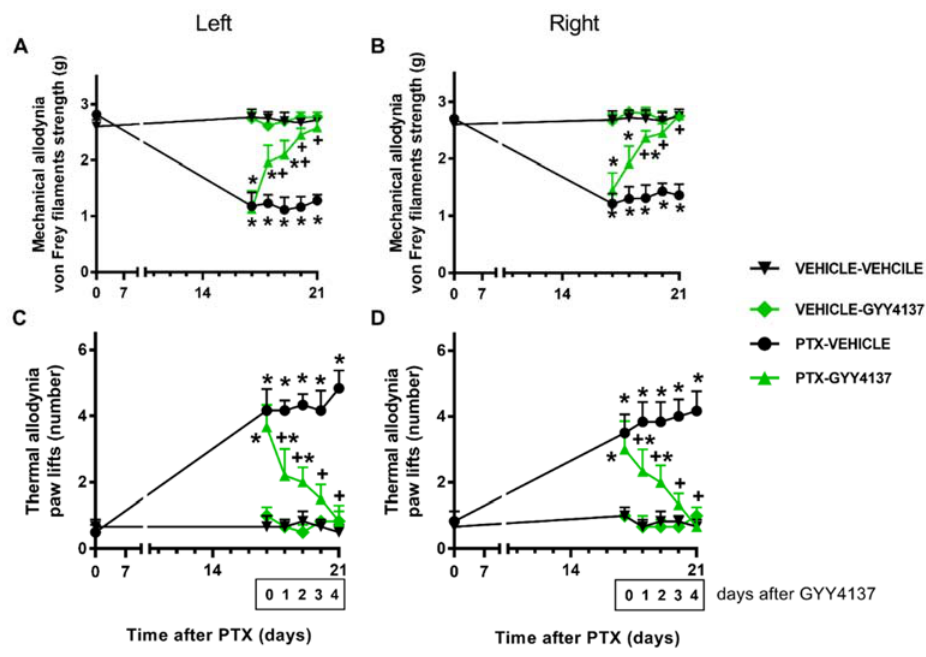
Figure 4. Effects of GYY4137 on PTX-induced nociception. Mechanical ( A : left paws; B : right paws) and cold ( C : left paws; D : right paws) antiallodynic effects produced by the repeated administration of 35 mg/kg of GYY4137 or vehicle for four days from days 18 to 21 after PTX injection. In all graphs, for each day and treatment evaluated, * indicates significant differences vs. the vehicle–vehicle-treated animals, and +, vs. the PTX–vehicle-treated animals ( p < 0.05, one-way ANOVA followed by the SNK test). Results are shown as mean values ± SEM; n = 6 animals per experimental